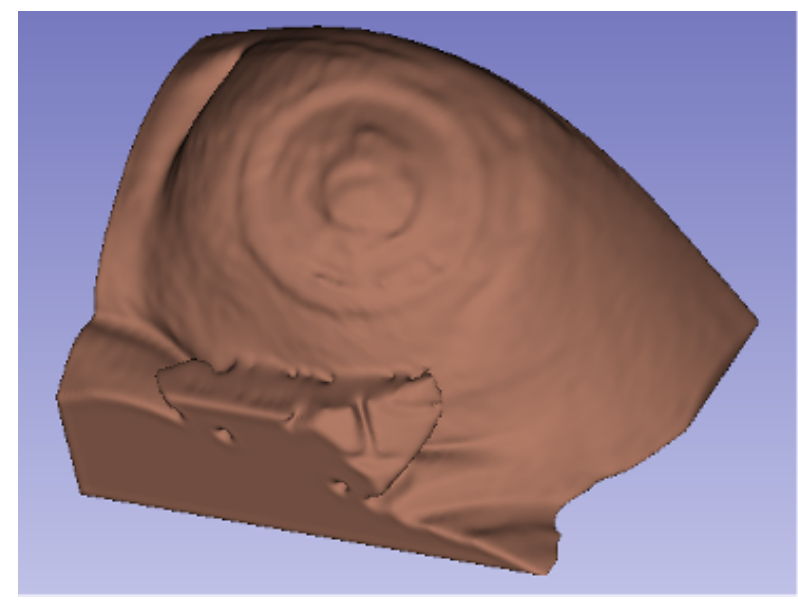
Figure 11. Final 3D volume of the ROI obtained by 3D